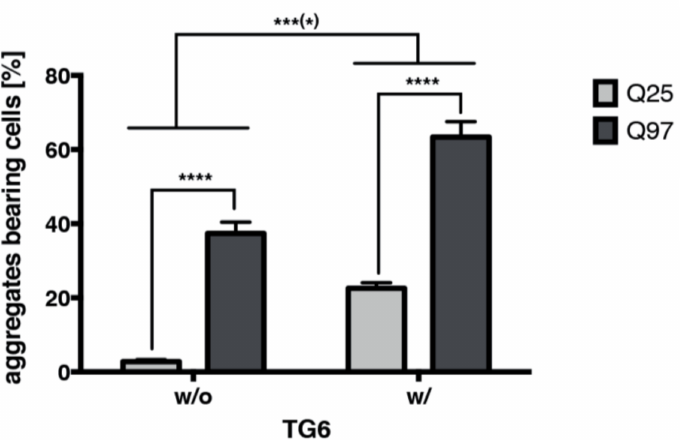
Figure 7. TG6 enzymatic activity increases the total amount of mutant huntingtin exon 1 aggre- gates. For quantification of mutant exon 1 GFP aggregates, SH-SY5Y cells were transiently (double) transfected with the exon 1 variants and with (w/) or without (w/o) an enzymatically active TG6 protein. Percentage of transfected cells containing aggregates for each of the exon 1 GFP fragments was quantified. Data are mean ± SEM of three independent experiments counting at least 200 cells per approach. Approaches were done in triplicates. For statistical analysis two-way ANOVA and Bonferroni post-test were used. Statistical significance is indicated by *** p < 0.001, **** p < 0.0001.,